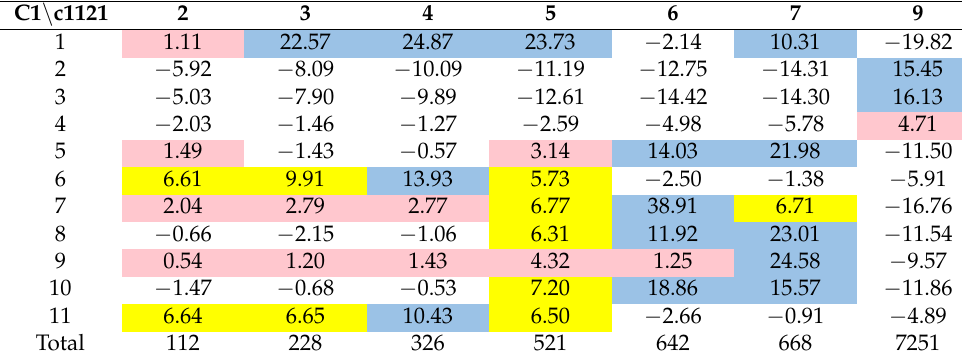
Table A2. Theoretical frequencies DUF 2018 (C1 \ c1121).